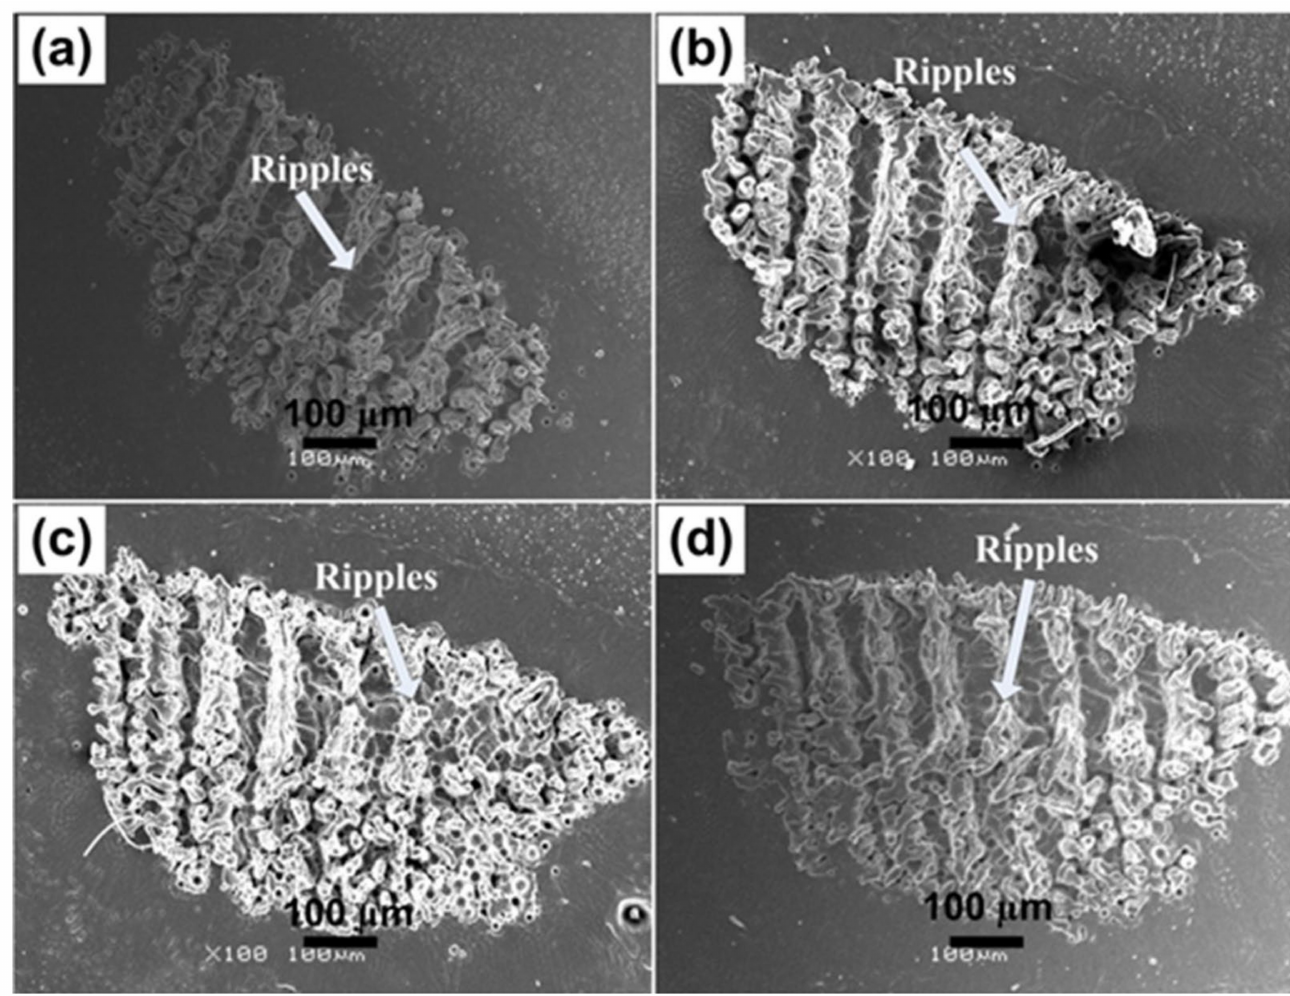
Figure 1. SEM images revealing the surface morphology of Al exposed to 100 pulses of ns laser at wavelength of 248 nm, pulse duration of 18 nm and repetition rate of 20 Hz at various fluences of ( a ) 0.86 J · cm − 2 , ( b ) 1 J · cm − 2 , ( c ) 1.13 J · cm − 2 and ( d ) 1.27 J · cm − 2 under an ambient environment of Ar at a pressure of 100